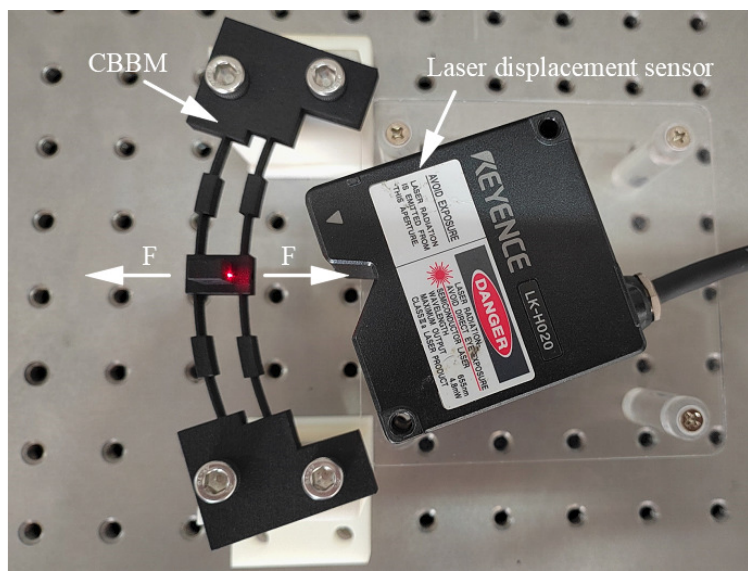
Figure 16. Pitch stiffness in experimental